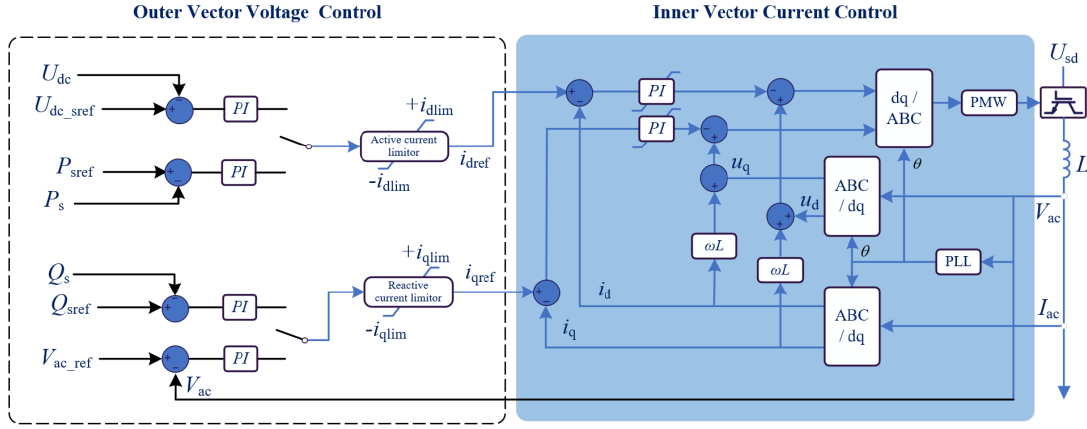
Figure 2. The direct current control of an MMC.